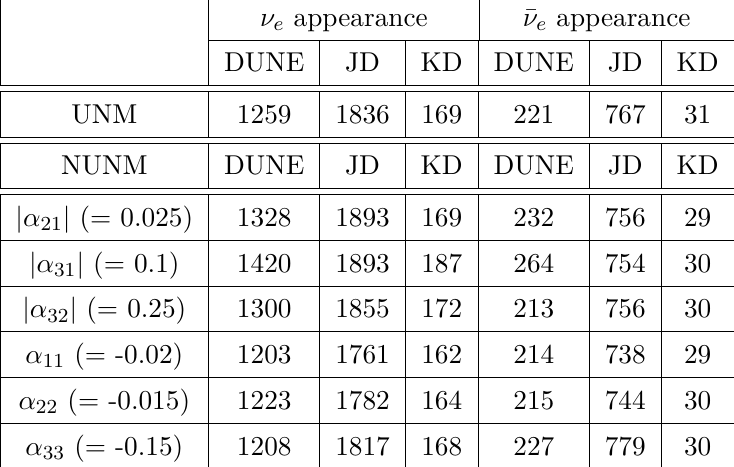
Table 4 . Comparison of the total signal rate for the ν e and ¯ ν e appearance channels in DUNE, JD, and KD setups in UNM case as well as in presence of various NUNM parameters. The relevant features of these facilities are given in table 3. The values of the standard oscillation parameters used to calculate event rate are quoted in table 2. The phases associated with the off-diagonal NUNM parameters are considered to be